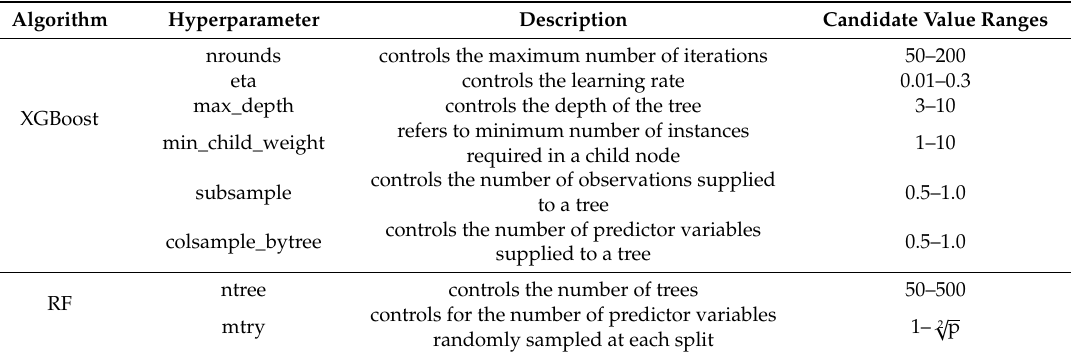
Table 3. Hyperparameters optimized for the XGBoost and RF algorithms and corresponding candidate value ranges for the random